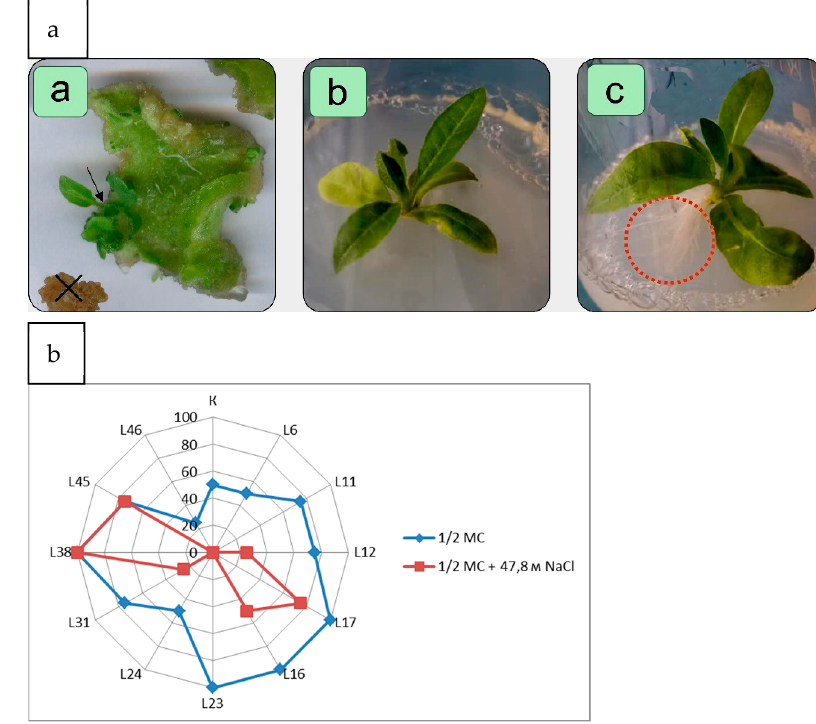
Figure 2. Effect of increased NaCl content on the growth of in vitro plant regenerates: ( a ) Regeneration of shoots and growth individual of the shoots of tobacco ( а —shoot formation on leaf explants of tobacco after transformation on medium Tm; b—a shoot of the untransformed line on medium Tp with NaCl; с —a shoot of the transformed line on medium Tp with NaCl). ( b ) The efficiency of rhizogenesis on medium Tp supplemented with 100 mg L − 1 Km (% root formation). Symbols: arrow —emerging shoot; X—died explant; red circle—regenerant rooting; blue line—Tp; red line—Tp + 50mM NaCl.